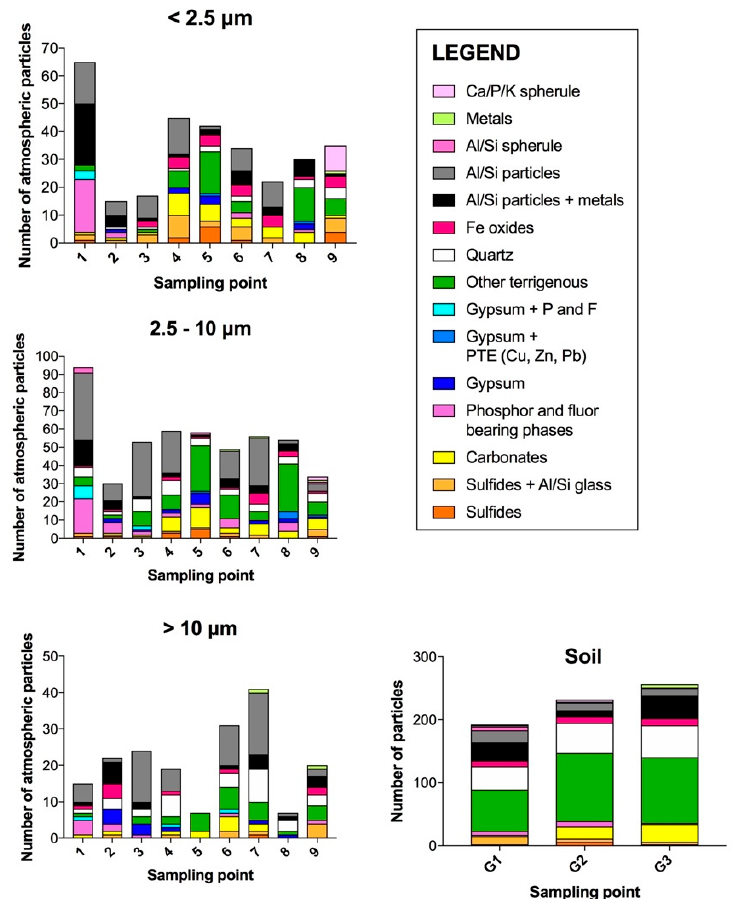
Figure 5. Mineralogical phases reported for particles deposited on Populus nigra italica leaves and soils collected in August 2018 in the vicinity of Olmaliq city.